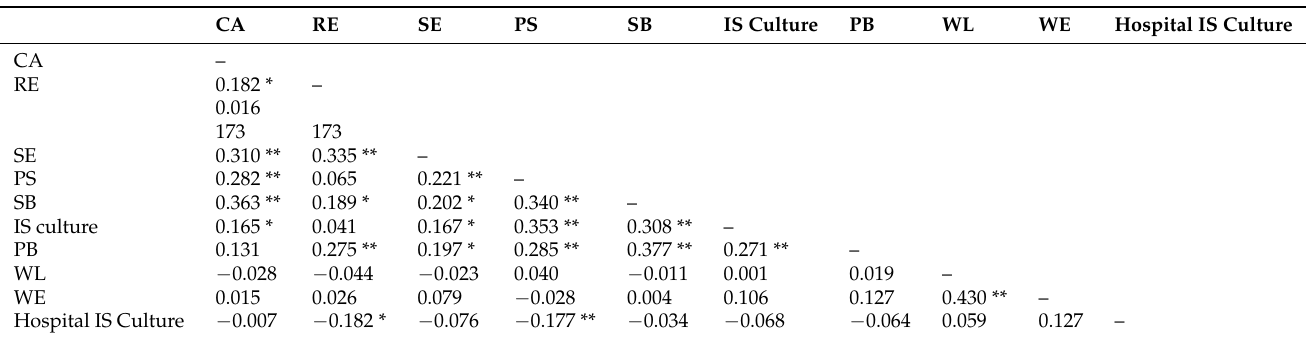
Table 9. Correlations between perception and work